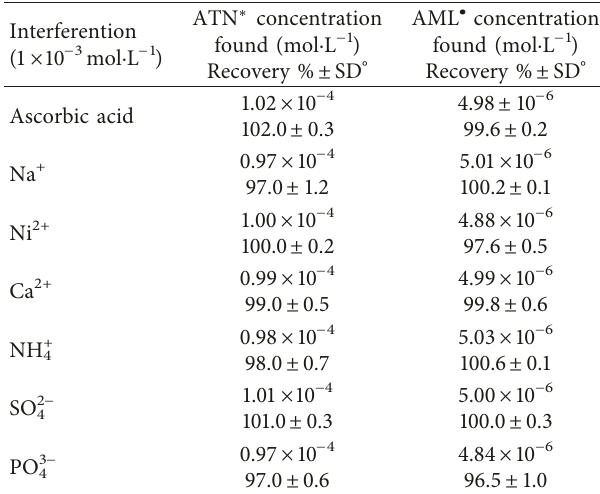
Table 1: Statistical parameters of the proposed method. Table 2: Effect of interferents on the determination of ATL and AML.